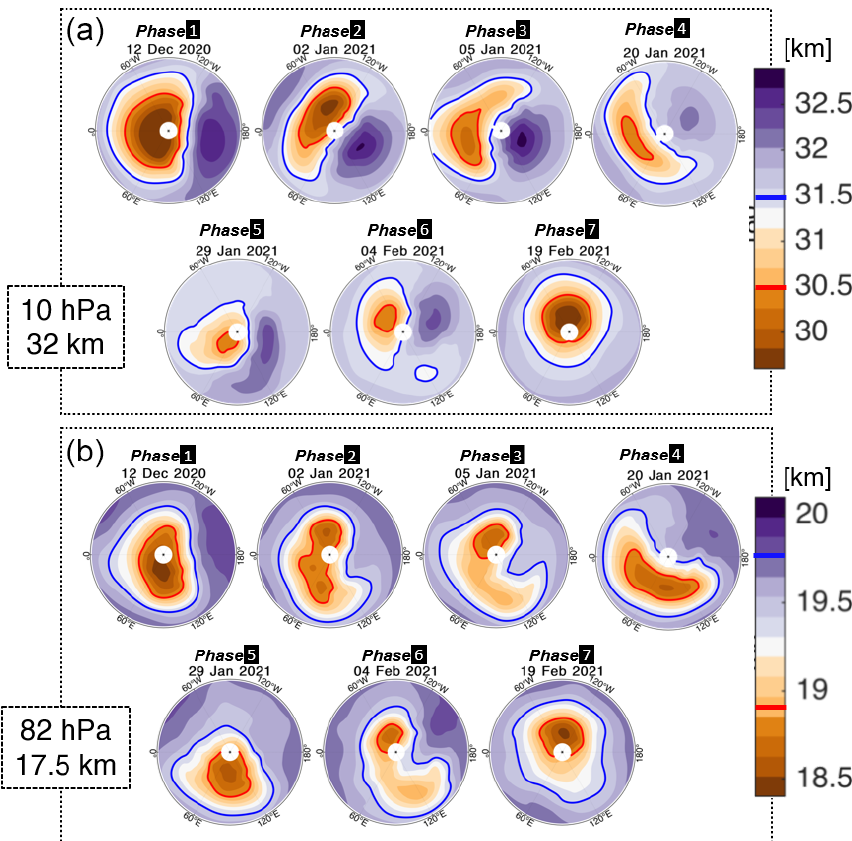
Figure 9. Maps of MLS (a) 10hPa and (b) 82hPa GPH in kilometres for selected days. Selected contours have been highlighted in blue and red, with their locations indicated on the colour